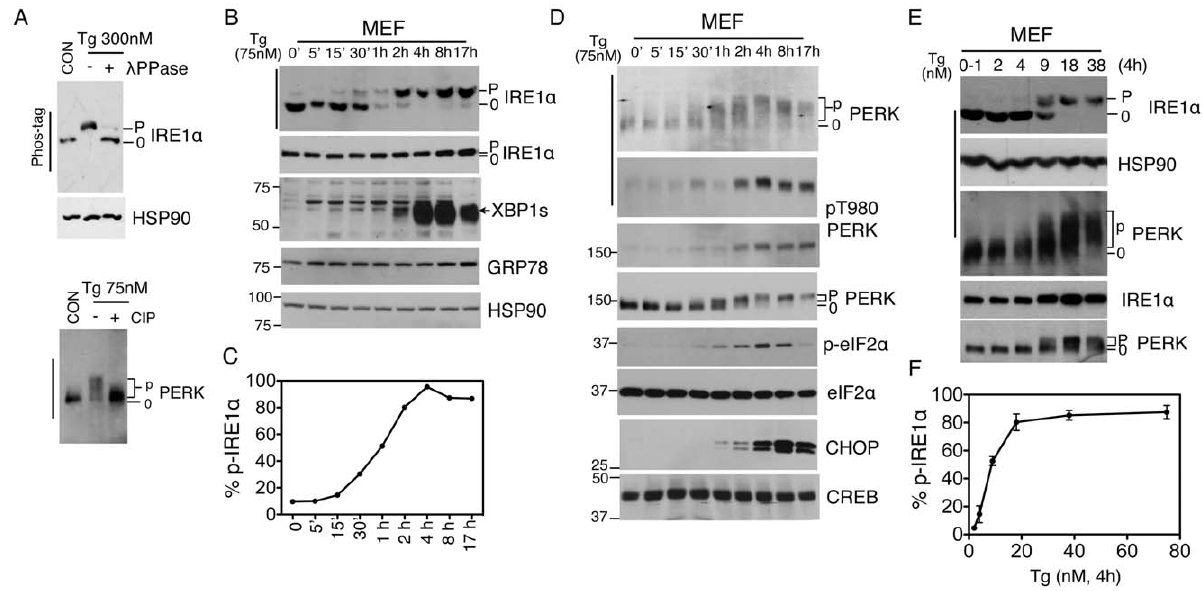
Figure 1. Visualizationand quantitationof ER stress under pharmacological stress. ( A ) Immunoblots of IRE1 a (upper)andPERK (lower) proteins in Tg-treated MEFs treated with or without l PPase or CIP. ( B and D ) Immunoblots of IRE1 a ( B ) and PERK ( D ) using the Phos-tag vs. regular gels. MEFs were treated with 75 nM Tg at indicated period of time. ( C ) Quantitation of percent of phosphorylated IRE1 a in total IRE1 a protein in Phos-tag gels shown in B . ( E ) Immunoblots of IRE1 a and PERK in wildtype MEFs treated with Tg at indicated concentrations for 4 h. ( F ) Quantitation of percent of phosphorylated IRE1 a in total IRE1 a protein in Phos-tag gels in E . HSP90 and CREB, loading controls. Phos-tag gels are indicated with a bar at the left-hand side. ‘‘0’’ refers to the non- or hypophosphorylated forms of the protein whereas ‘‘p’’ refers to the phosphorylated forms of the protein.